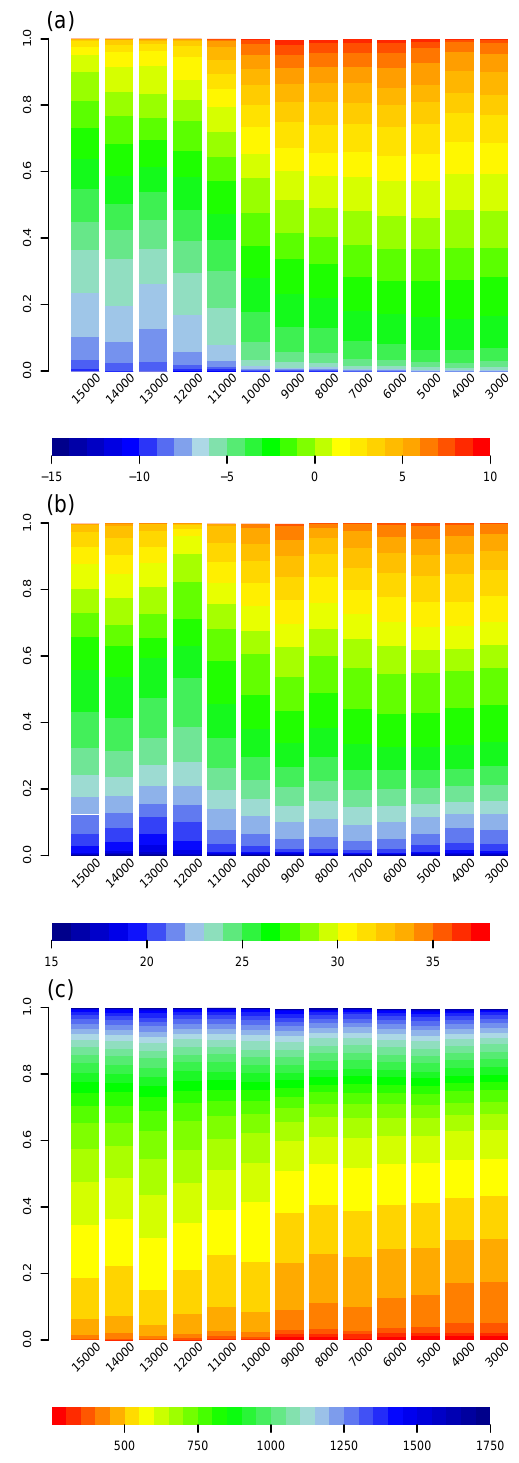
Figure 3. Distribution of the reconstructed climate variables in the Iberian Peninsula and Balearic Islands in the last 15kyr. Colours show the proportion of area covered with each class of (a) min- imum temperature of January, (b) maximum temperature of July, and (c) annual